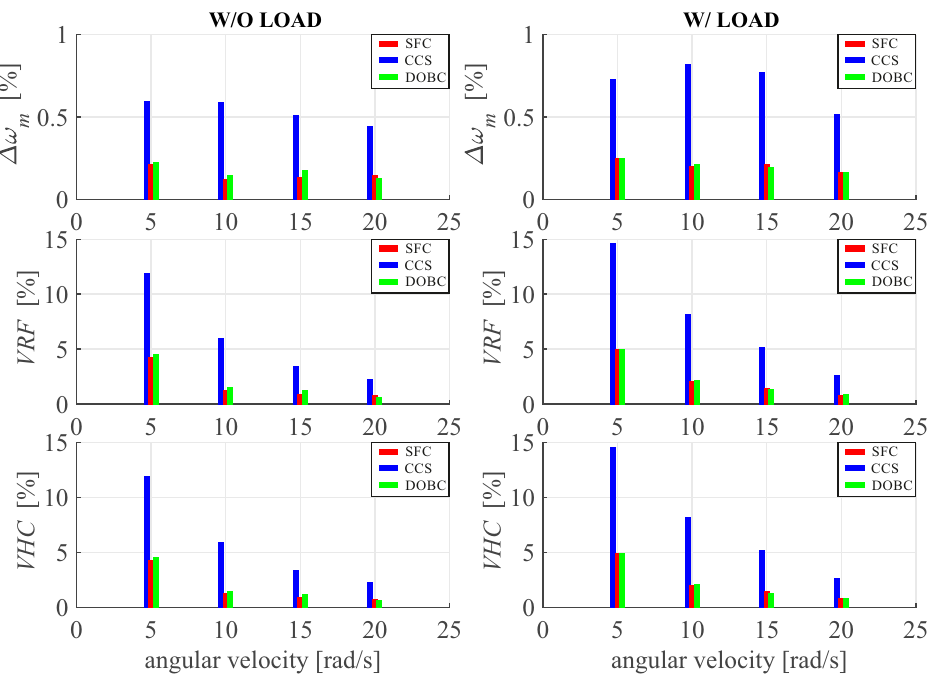
Figure 13. Bar chart of calculated velocity indicators for selected angular speeds without and with